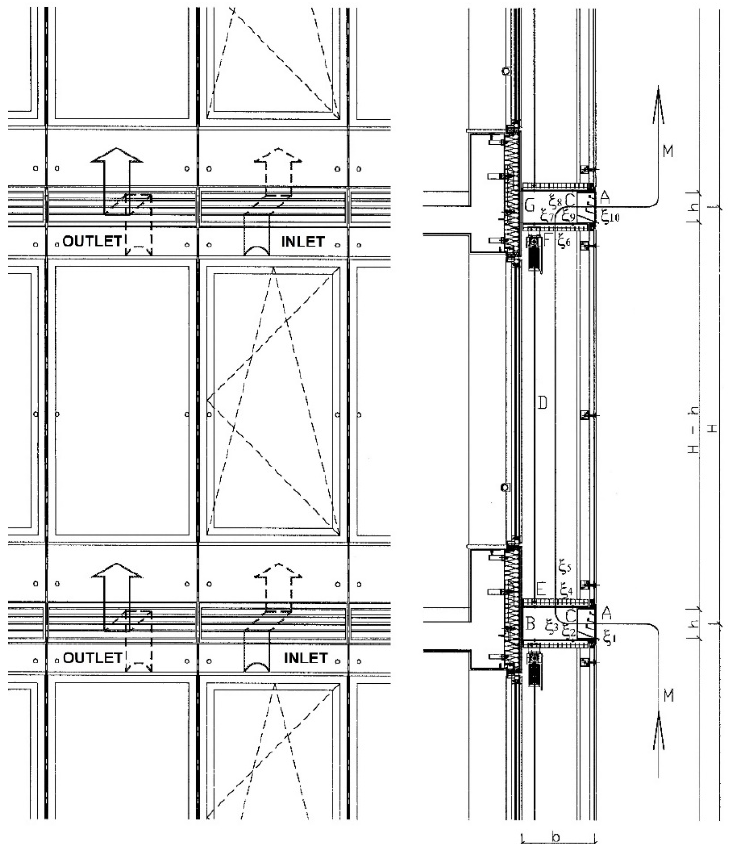
Figure 2: Basic scheme for the definition and quantification of aerodynamic resistances of double skin transparent facade with open circuit A – convection anti rain or aerodynamic shutter, B – inlet air channel, C – bird and insect net, D – cavity of climate facade, E – walkable removable – openable grate, F – floor grate, G – outlet air channel, H – height of the cavity section (m), h – height of the openings of the distribution air channels (m), b – width of the cavity, L – length of the cavity section (m), M – air flow trajectory. ξ x - aerodynamic coeflcient of local resistance of airflow, in particular: ξ 1 - at inlet on aerodynamic louvers "A", ξ 2 - on protective screen "C" at inlet, ξ 3 - where flow direction changes from inlet channel "B" to the cavity "D", ξ 4 - on grille - grid "E" during flow from inlet channel "B" to the cavity "D", ξ 5 - upon sudden increase in diameter during movement of airflow from inlet channel "B" to cavity "D", ξ 6 - on grid "F" during flow from cavity "D" to outlet channel "G", ξ 7 - upon sudden decrease in diameter during movement of airflow from cavity "D" to outlet channel "G", ξ 8 - upon change of direction of movement from cavity "D" to outlet channel "G", ξ 9 - on protective screen "C" at outlet, ξ 10 - on aerodynamic louvers "A" at